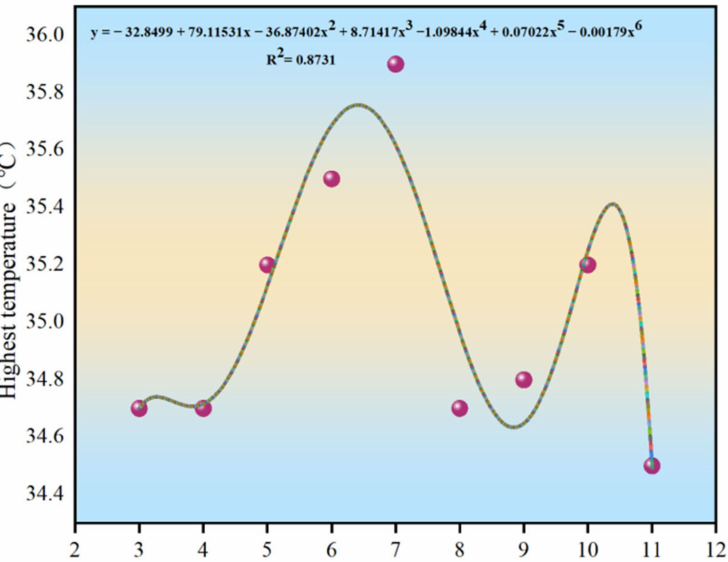
Figure 5. Distribution curve of the maximum